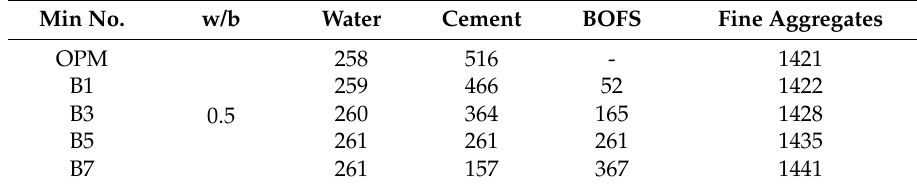
Table 2. Mix designs (kg/m 3 ).